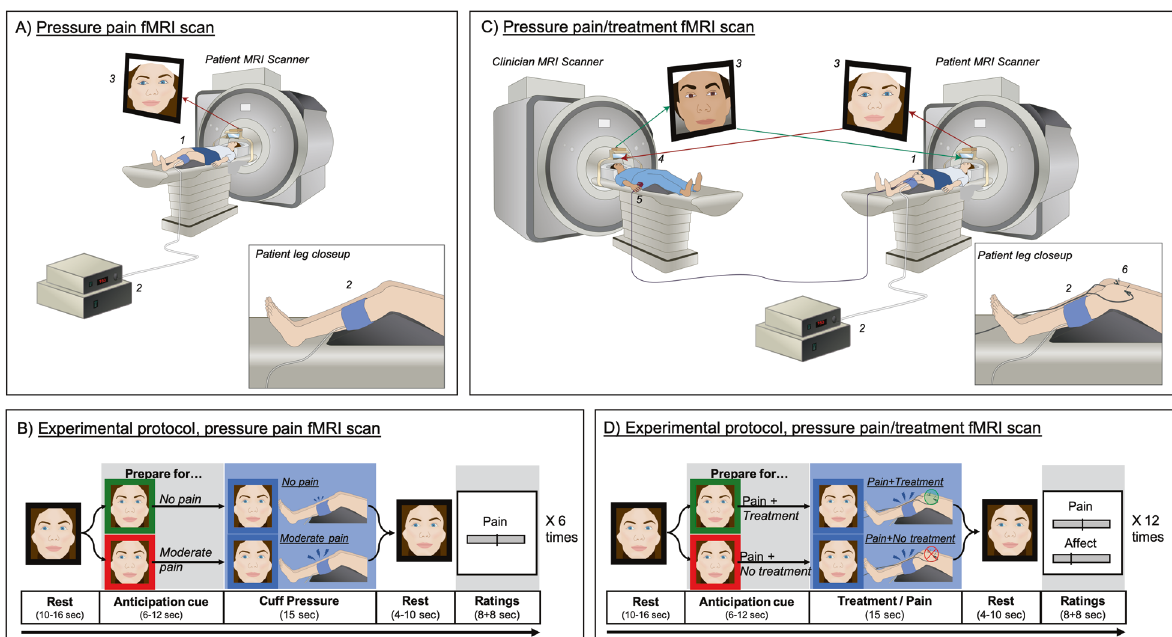
Fig. 1 fMRI hyperscanning experimental environment and protocol. A In an initial “ pain MRI ” , the patient (1) received a series of moderately painful and nonpainful leg-cuff-pressure stimuli (2) while the clinician observed. Video recordings of patients ’ facial expressions (3) during moderately and nonpainful cuff pressure were used in a machine learning classi fi er to identify facial expressions indicative of painful relative to nonpainful states. B Each pain MRI consisted of six repeated trials (three moderate pain, three no pain) in a pseudorandomized order. After a resting period, patients were shown a visual cue indicating whether the upcoming cuff pressure would be non-painful (green frame) or painful (red frame). Following this anticipation cue, patients received either innocuous (30 mmHg) or painful (individually calibrated to evoke moderate pain) cuff-pressure stimuli to their left leg. After each trial, patients rated pain intensity on a Visual Analog Scale. C In the subsequent “ pain/treatment MRI ” , the clinician (4) used a button box (5) to apply remotely activated subliminal electroacupuncture treatment (6) to the patient (1) while they received moderate cuff-pressure pain (2). In-scanner videos (3) were recorded and used for automated facial- feature extraction to investigate causal dynamics in nonverbal communication between the patient and the clinician, and their association with brain-activity concordance assessed with simultaneous fMRI. D Each pain/treatment MRI consisted of 12 trials (four verum, four sham, and four no treatment) in a pseudorandomized order. After a rest period (left), both participants were shown visual cues, indicating whether the next pain stimulus, applied to the patient, would be treated (green frame) or not treated (red frame) by the clinician (Anticipation phase). Next, patients received moderately painful cuff-pressure stimuli to their left leg, while clinicians applied or did not apply treatment, according to the preceding anticipation